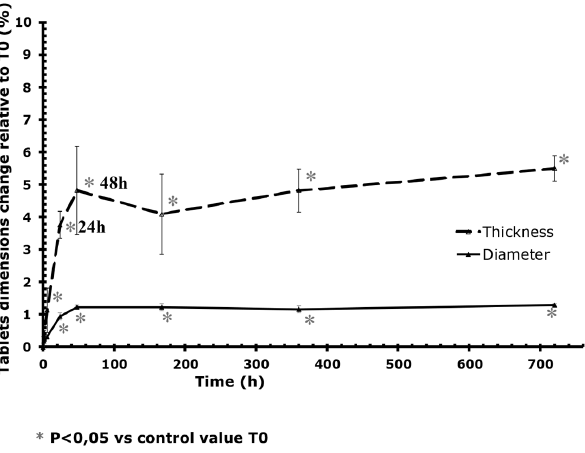
Fig. 4. Changes over time in the diameter and thickness of tablets stored at 25 ˚ C/60% RH in comparison with T0 over time. The vertical bars represent the 95% confidence interval limits for respectively the measured diameter variation and the measured thickness variation.